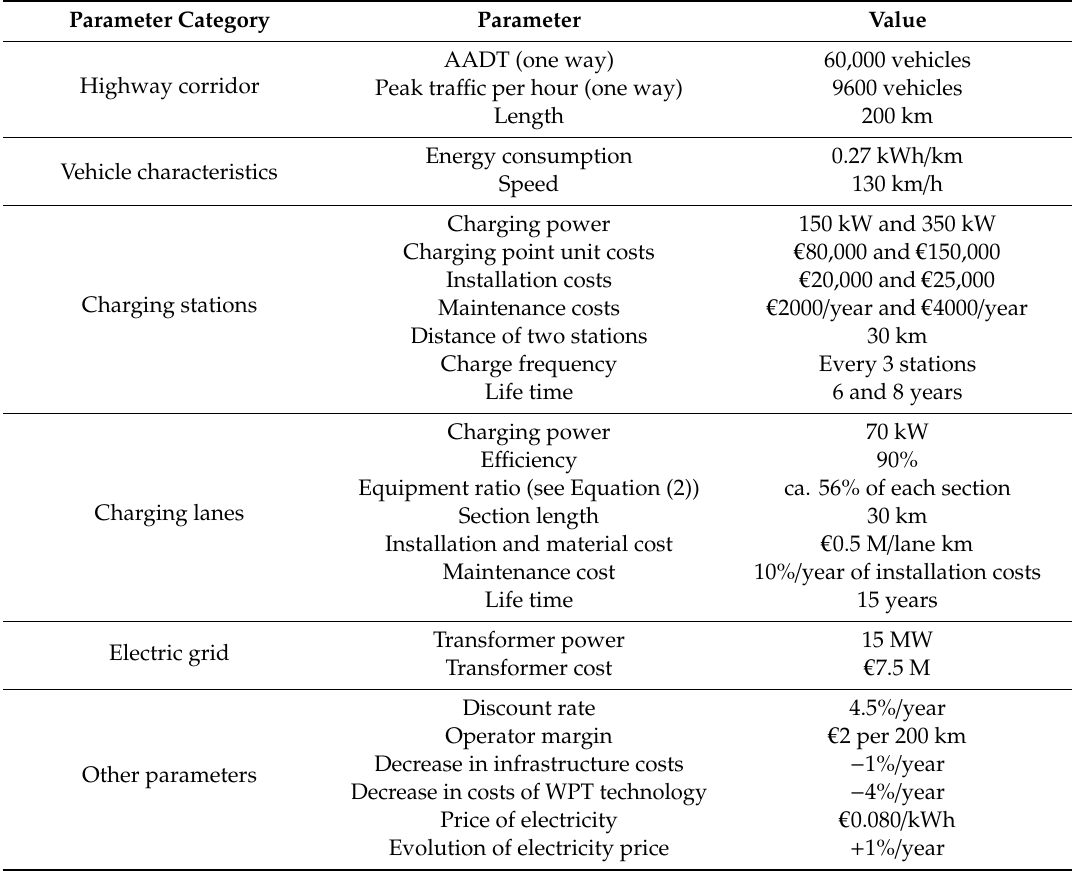
Table 1. Values of simulation parameters.